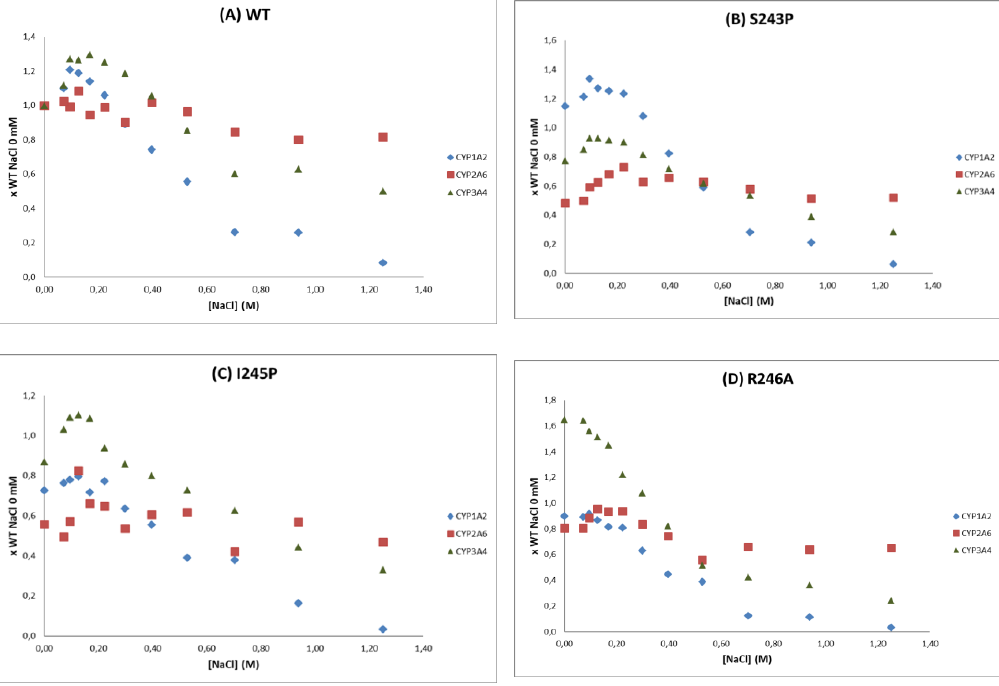
Figure 3. Relative CYP-reaction velocities ( k obs ) of CYP1A2, 2A6 and 3A4 in function of the NaCl concentration, when combined with CPR WT ( A ) or mutants S234P ( B ), I245P ( C ) and R246A ( D ). Velocities were normalized with the one observed when combined with WT CPR at 0 M NaCl.